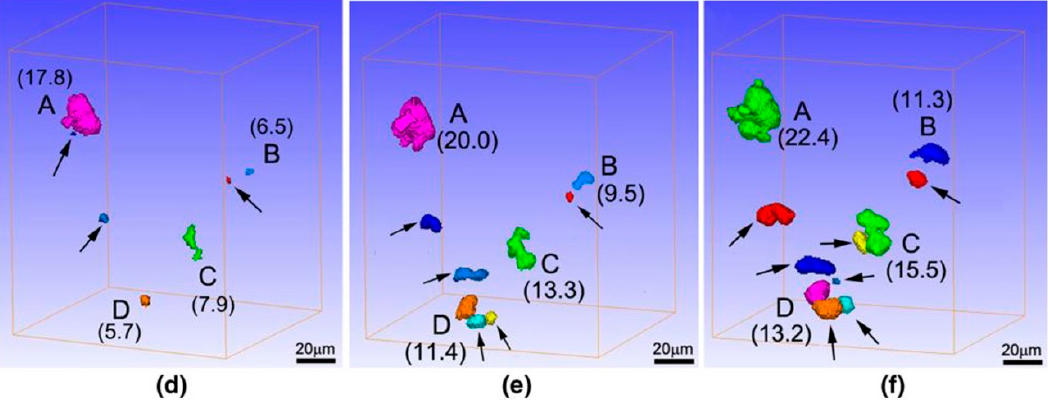
Figure 5. XRT volume renderings of micro-pores in a same sample with a heat treatment at 1603 K for ( a ) 0 h, ( b ) 1 h, ( c ) 4 h, ( d ) 7 h, ( e ) 12 h, and ( f ) 20 h. The equivalent diameter (µm) of the S-pores is also given